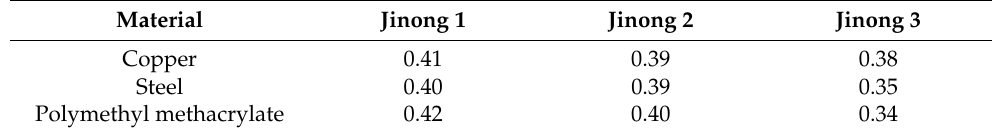
Table 5. Static friction coefficient for different varieties of Cyperus esculentus seeds.